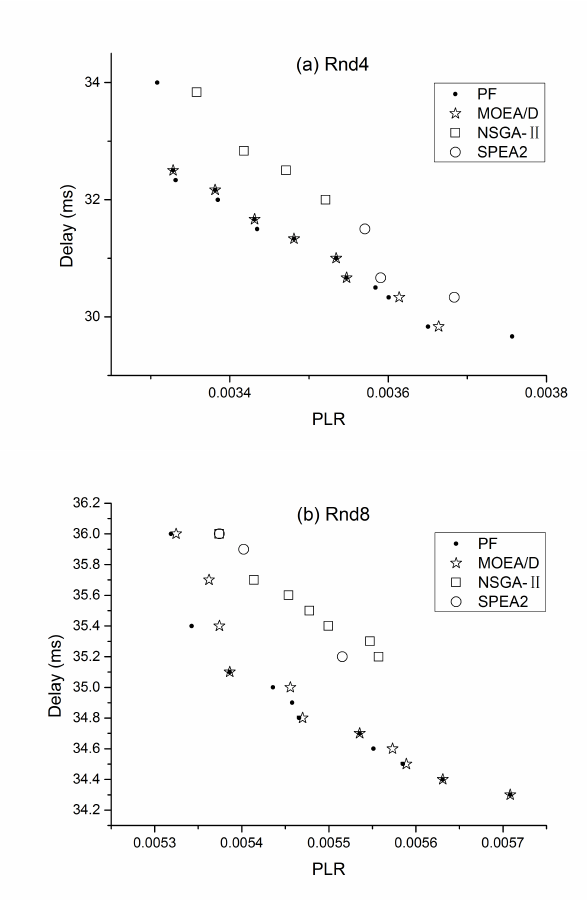
Figure 1: Example of the PFs obtained by different algorithms. (a) Rnd4 network. (b) Rnd8 network. a number of widely used performance measures, i.e. invert- ed generational distance, generational distance,